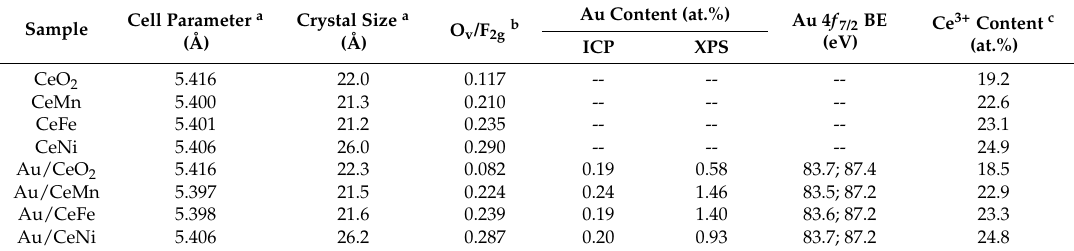
Table 2. XRD and XPS results of CeO 2 , CeM mixed oxides with different dopants and corresponding supported Au/CeM catalysts (M = Mn, Fe and